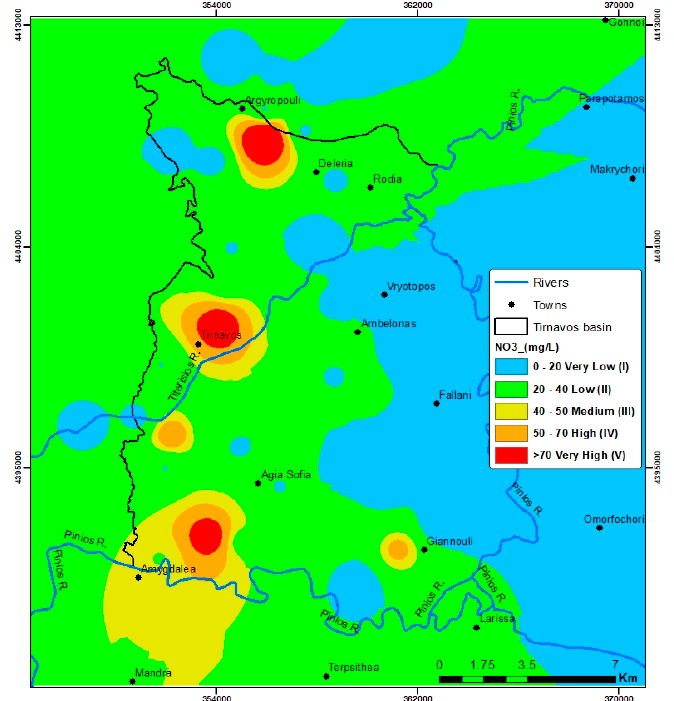
Figure 10. Spatial distribution map of nitrates concentrations (average values of four periods, Sep-